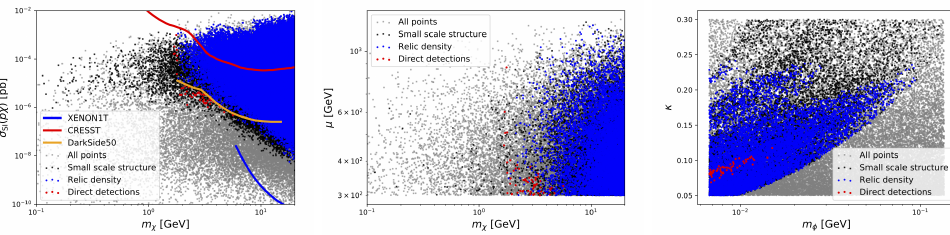
Figure 4 . The scatter plots of parameter space that pass the preselections (grey box). The small scale structure constraint (black box), DM relic density constraint (blue dot) and DM direct detection constraints (red dot) are applied in